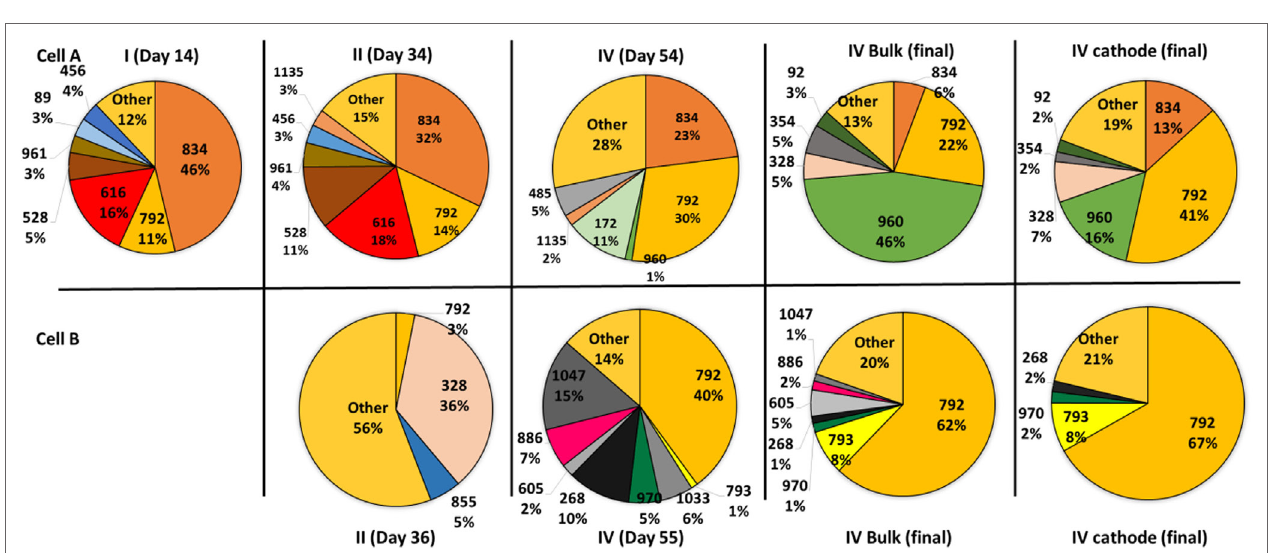
FigUre 3 | Pie charts showing the relative abundance of the operational taxonomic units that contribute more than 1% to the total community according to 16S rRNA gene pyrosequencing analysis. The samples were taken during the four periods from the suspended cells. At the end of the operation, samples from the biofilm attached to the cathodes were also analyzed. The samples obtained from the bulk solution are indicated by the day of sampling and the samples taken from the biofilm of the cathodes at the end of the experiments are indicated by the day of sampling and the word cathode. The sample from cell B taken during the first period could not be analyzed due to the low biomass content.